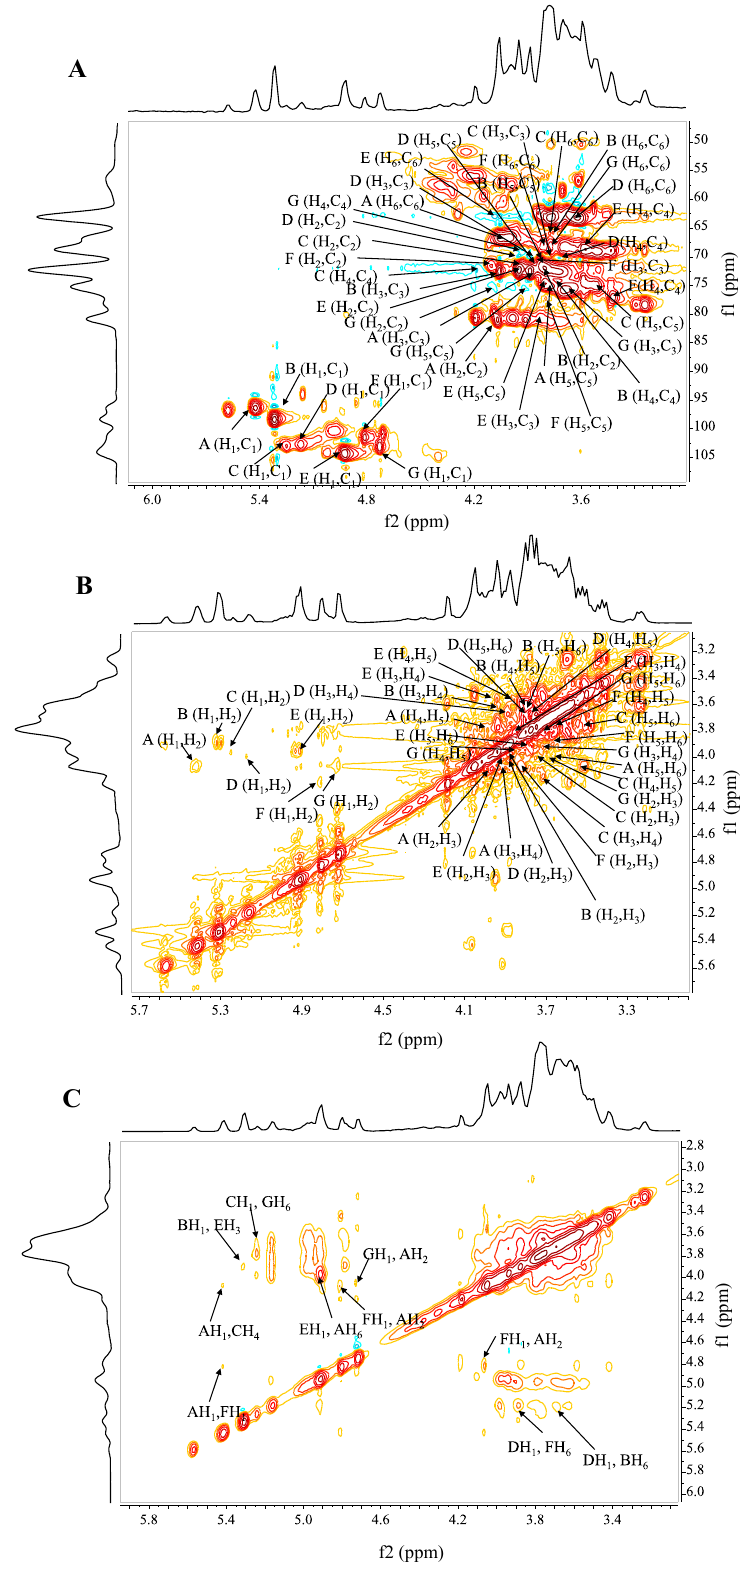
Figure 4. NMR spectrum analysis of S2. ( A ) 1 H- 13 C HSQC spectrum, ( B ) 1 H- 1 H COSY spectrum, ( C ) NOESY spectrum.